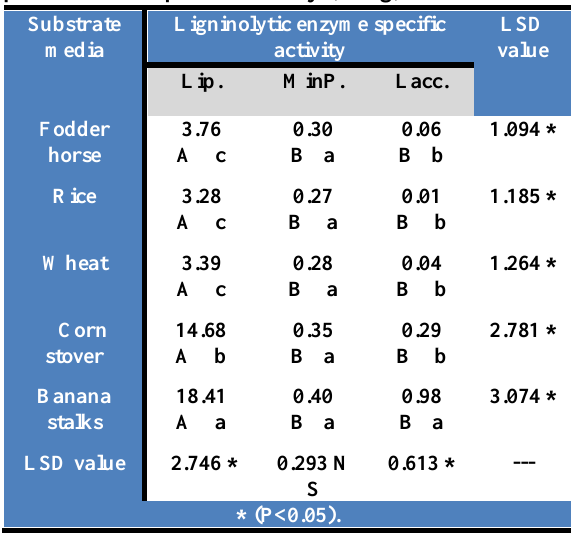
Table, 2: Effect of substrate media and enzymes production in specific activity (U/mg).